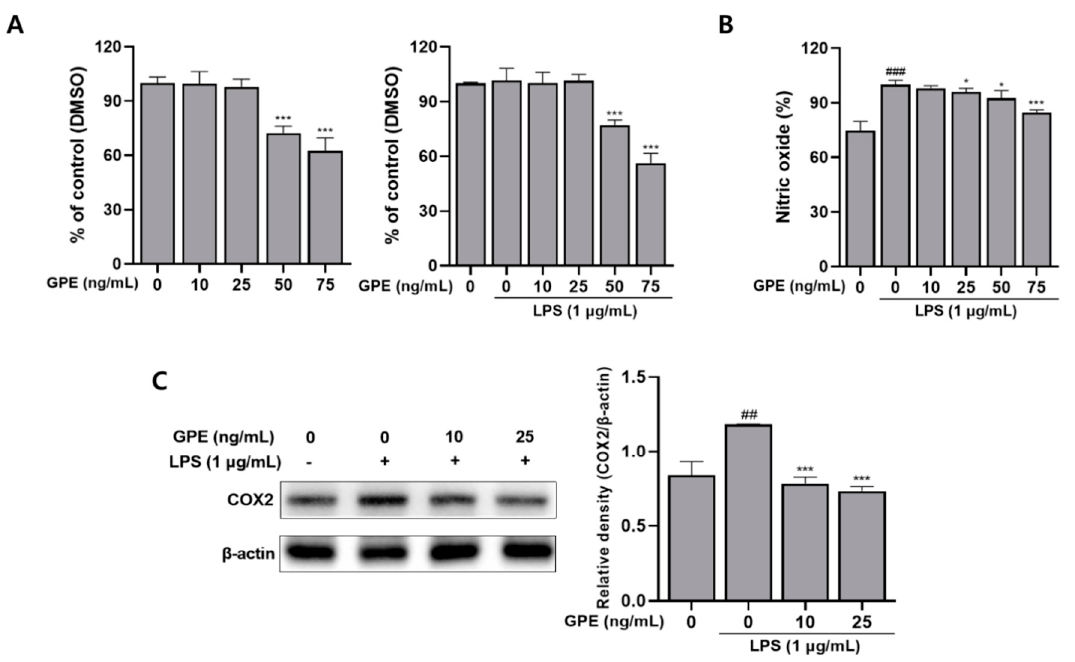
Figure 3. ( A ) Effect of GPE with or without LPS-induced cell viability in RAW264.7 cells. ( B ) Effect of GPE on LPS-induced production of the inflammatory mediators NO. ( C ) Effect of GPE on LPS-induced COX-2 protein expression level in RAW264.7 cell. The results obtained from three independent experiments were expressed as mean ± standard deviation (SD), compared with the control group. ## p < 0.005 and ### p < 0.001 vs. untreated group; * p < 0.05, *** p < 0.001 vs. LPS-treated group. GPE; Gynura procumbens polyphenolic extract, COX-2; cyclooxygenase-2.